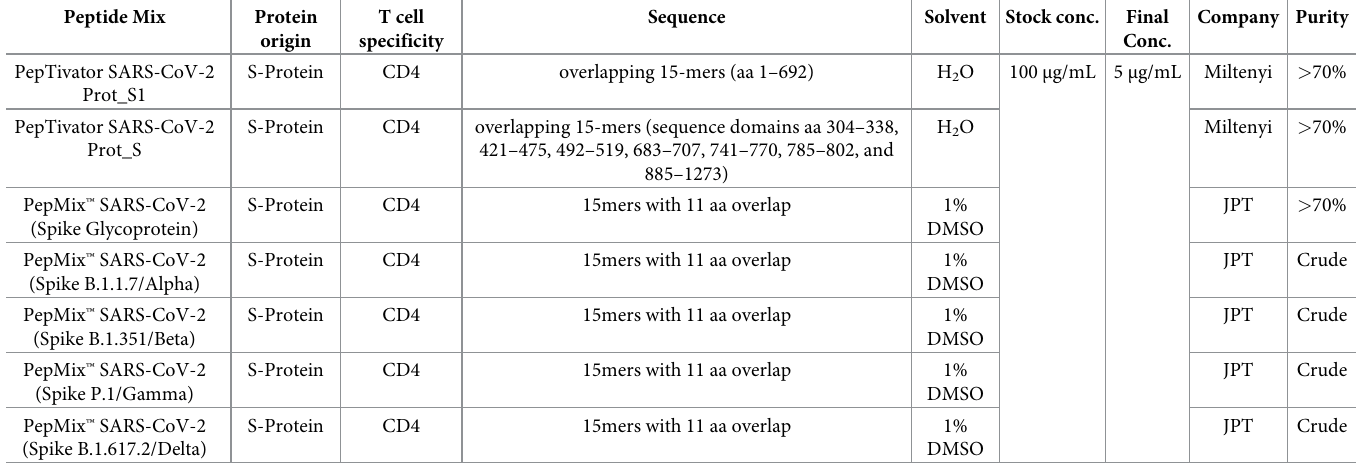
Table 1. SARS-CoV2 spike protein-derived epitope peptide